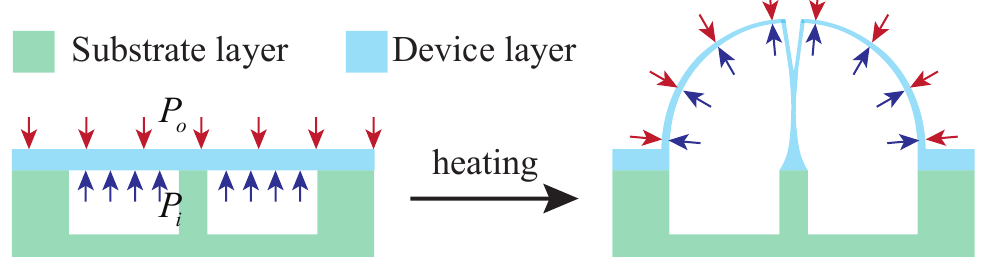
Figure 1. Cross-sectional schematic diagram of the blowing